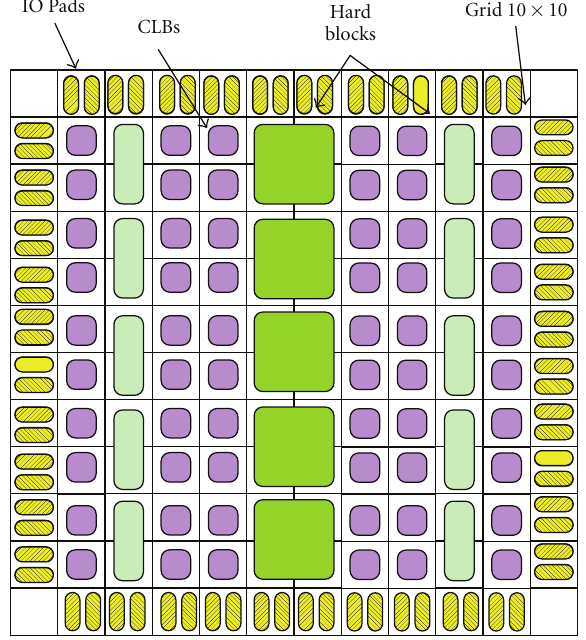
Figure 1: Mesh-based heterogeneous FPGA